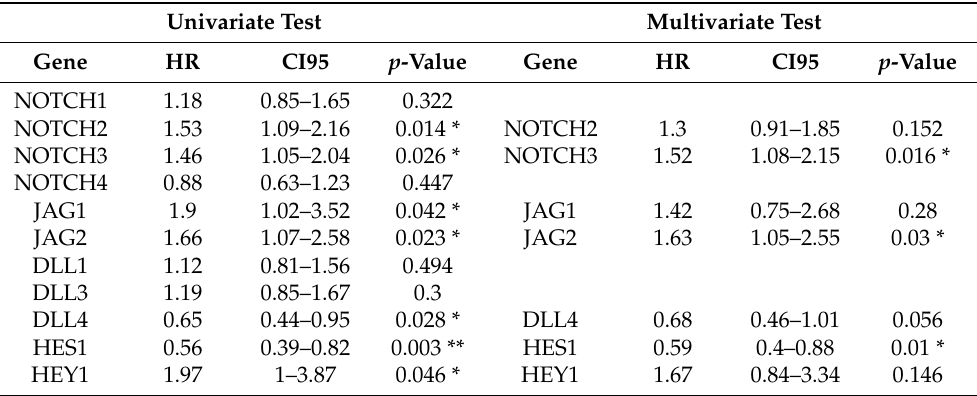
Table 5. Risk assessment of Notch components on